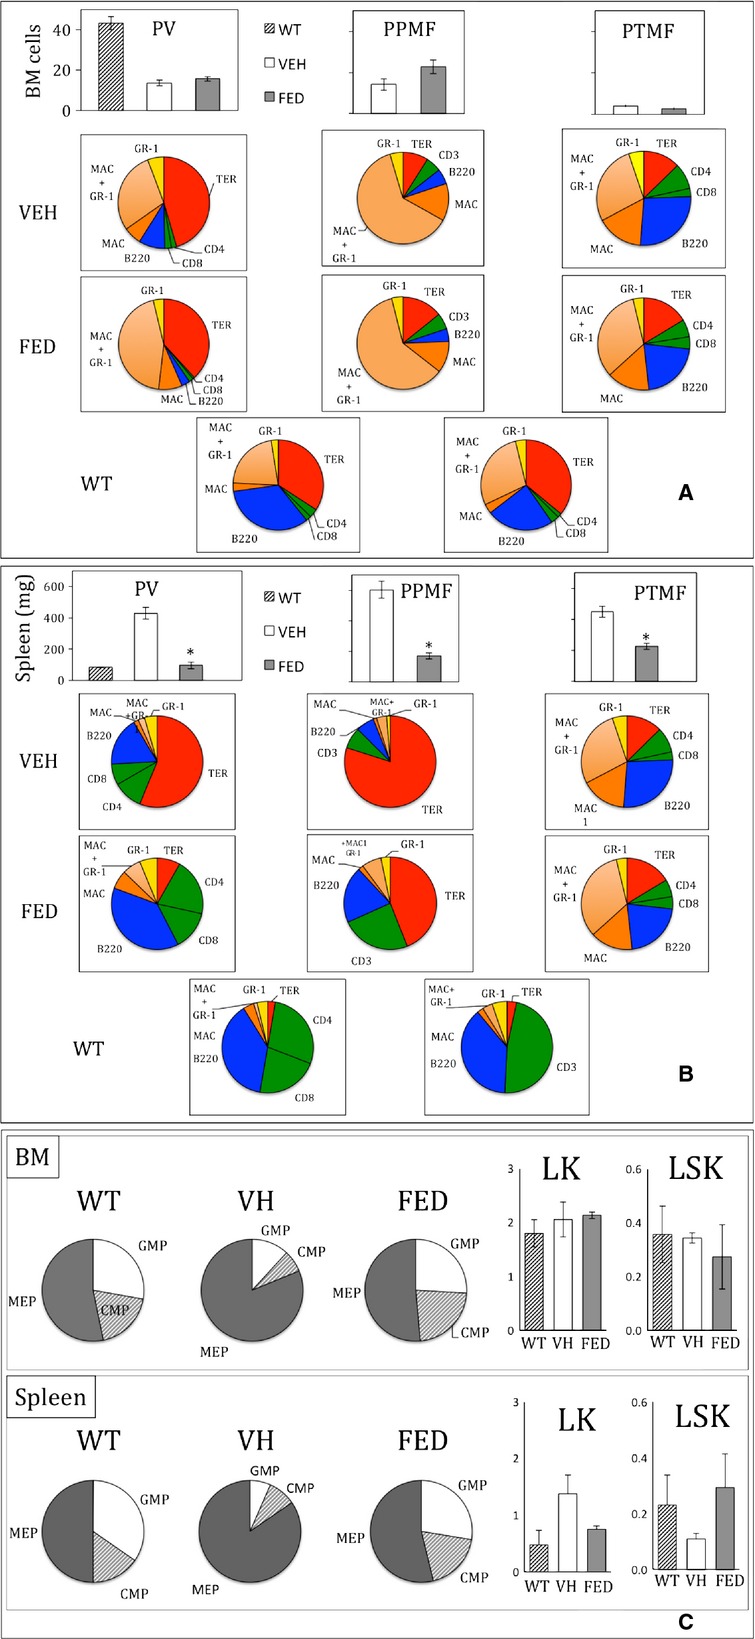
Effect of Fedratinib on BM and spleen cell composition of polycythemia vera (PV), post-PV myelofibrosis (PPMF) and rapid post-essential thrombocythemia MF (PTMF) mice. (A) BM cell numbers per femur (×106) (top) and cell type percentages in vehicle (VEH, top, white column)-, Fedratinib (FED, middle, grey column)-treated mice (n = 6–7) and normal WT C57/Bl6 mice (WT, bottom, striped column) (n = 4). Cell types were determined by FACS analysis with antibodies directed against Gr-1, CD11b (Mac1), Terr119/CD71 (TER), CD3 (or CD4 and CD8) and B220. (B) Spleen weight and cell type percentages in vehicle (VEH, top)-, Fedratinib (FED, middle)-treated mice (n = 6–7) and normal WT C57/Bl6 mice (WT, bottom) (n = 4). Cell types were determined by FACS analysis as in A. Normal spleen cell composition was restored by Fedratinib in the PV model. (C) Progenitor cell per cent in BM and spleen from WT C57/Bl6 mice (WT, bottom) (n = 3) and from mice developing PPMF and treated by Fedratinib (FED) or vehicle (VH) (n = 4). Lin− cell subpopulations (Gr1, CD11b, B220, CD3 and Ter119 negative) were identified according by FACS analysis: LSK (progenitor cells with multipotent activity, lin−, c-kit+, Sca-1+) and subpopulation of LK myeloid progenitor cells (Lin−, c-kit+) including MEP (megakaryocyte-erythroid progenitors, LK, CD34−, FcRgII/III−), GMP (granulocyte-macrophage progenitors, LK, CD34+, FcRgII/III high) and CMP (common myeloid progenitors, LK, CD34+, FcRgII/III low). Fedratinib restored normal proportions of MEP, GMP and CMP in BM and Spleen. All experiments were carried out at the end of treatment, after around 8, 10 or 15 weeks of treatment in the PTMF, PPMF or PV models respectively. Results represented the percent of cell types per singlet and are mean values ± SEM, *P ≤ 0.05.